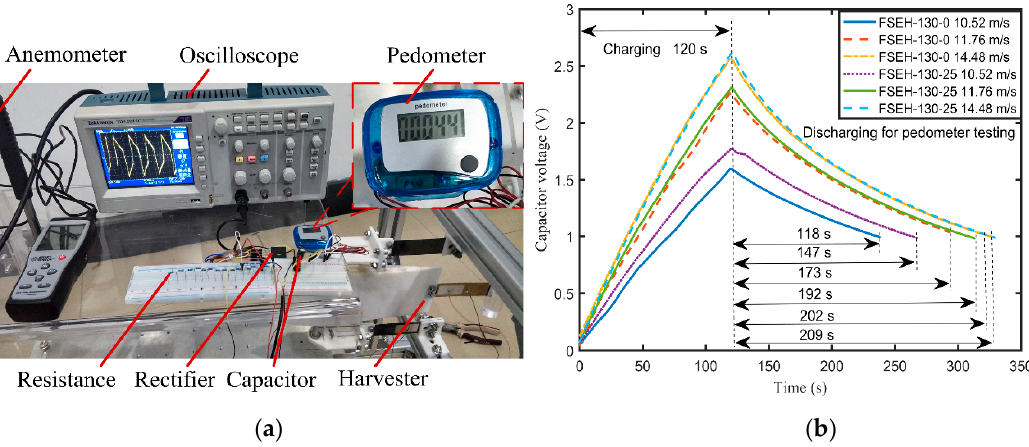
Figure 14. Experimental device of the energy collecting and storing circuit, and the variation of the capacitor voltage with time for the pedometer testing at various velocities: ( a ) energy collecting and storing circuit; and ( b ) capacitor voltage for pedometer testing.